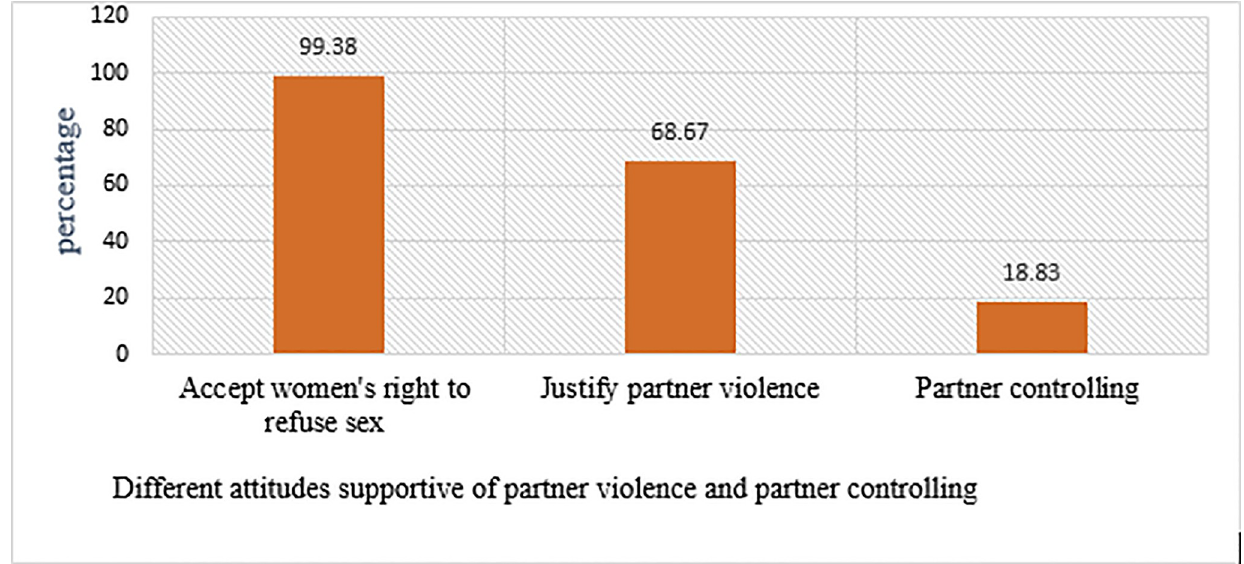
Fig 1. Proportion of respondents having different perception that might justify partner violence and partner controlling among women who had given birth in public hospitals in Harari regional state, East Ethiopia, 2018–2019.